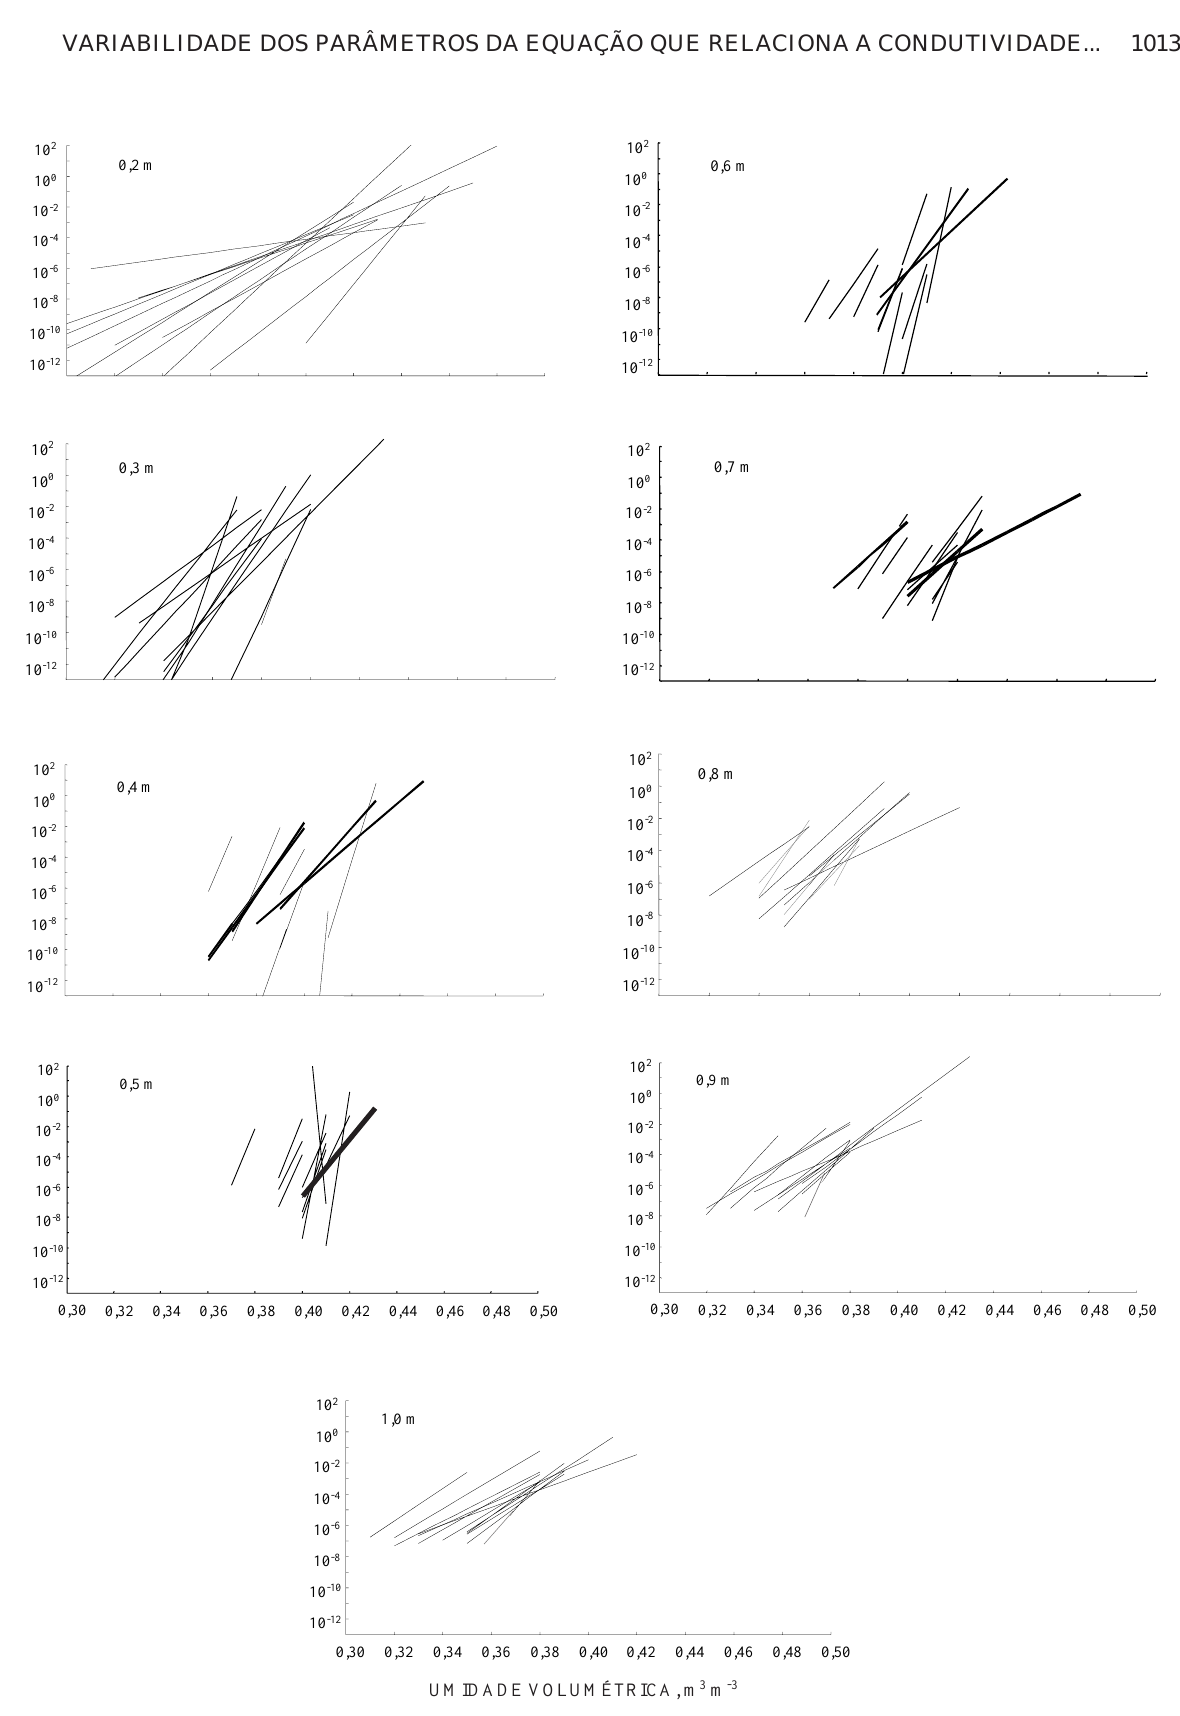
Figura 5. Condutividade hidráulica em função da umidade para os 12 locais avaliados. Linhas finas indicam observações nas quais a variação da umidade ao longo do experimento ( DqDqDqDqDq ) foi inferior ou igual a 0,03; linhas grossas referem-se a observações com DqDq DqDq Dq >